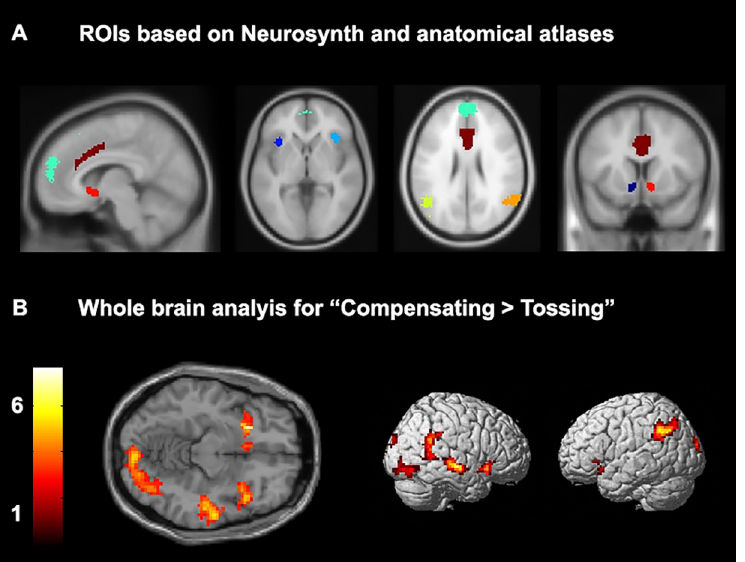
Fig 2. Representation of (A) Independently selected ROIs: dACC (dark red, most left picture), mPFC (turquoise, most left picture) bilateral insula (blue, second picture to the left), bilateral TPJ (green and orange, second picture to the right), and bilateral NAcc (dark blue and red, most right picture). See text for explanation of the selection procedure. See Table 1 for coordinates of center of mass. (B) Whole brain results for the contrast “ Compensating > Tossing ” , for a cluster-corrected threshold of p < .05 FDR-corrected, 101 contiguous voxels, at an initial threshold of p <